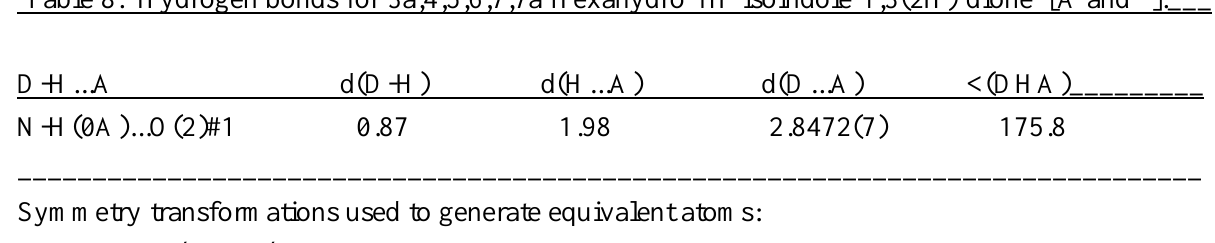
Table 8. Hydrogen bonds for 3a,4,5,6,7,7a-Hexahydro-1H-isoindole-1,3(2H)-dione [Å and